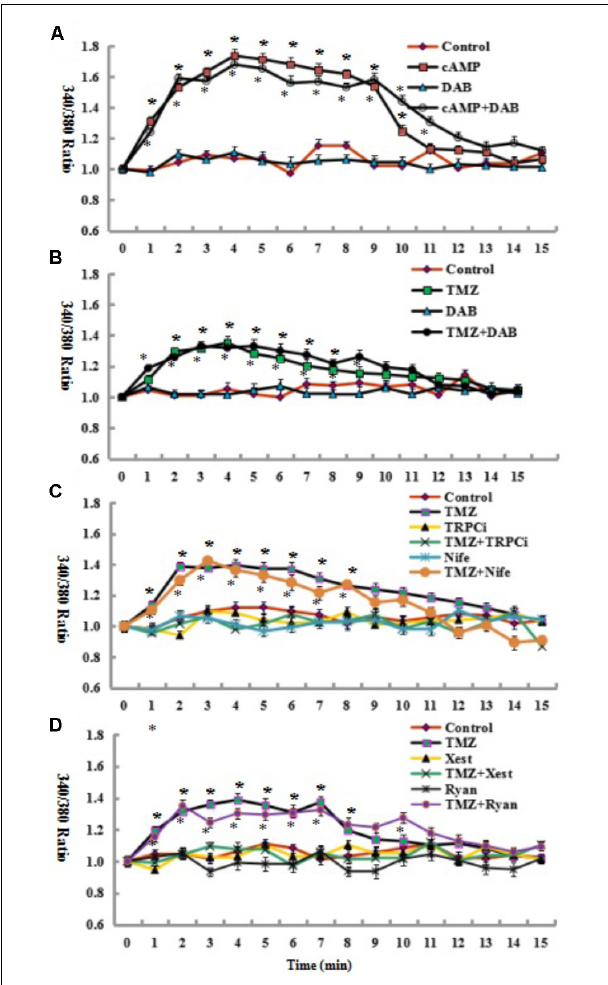
FIGURE 3 | Glycogenolysis is not required for the increase in [Ca 2 + ] i induced by the addition of 3 µ M cAMP or 5 µ M TMZ. (A) Following the incubation of fura-2-loaded cells in saline solution for 2 min and a subsequent washing step, the cells were perfused either in a similar solution or in a solution to which an additional 3 µ M cAMP had been added at zero time. In some experiments, 10 mM DAB, an inhibitor of glycogenolysis, was added 2 min before the addition of cAMP. All results (340/380 fluorescence ratio of fura-2) after the addition of cAMP and cAMP plus DAB were significantly different ( P < 0.05) from control conditions. (B) An increase in [Ca 2 + ] i by 5 µ M TMZ added at zero time was similarly unaffected by 10 mM DAB, added as in (A) . All results after the addition of TMZ and TMZ plus DAB were significantly different ( P < 0.05) from control conditions. (C,D) An increase in [Ca 2 + ] i by 5 µ M TMZ added at zero time was prohibited by the addition of 2 µ g/mL TRPC1 neutralizing antibody (TRPCi) and 1 µ M Xestspongin C (Xest), but not inhibited by 1 µ M Nifedipine (Nife), or 1 µ M Ryanodine (Ryan), added as in (A) . All results after the addition of TMZ, TMZ plus Nife, and TMZ Plus Ryan were significantly different ( P < 0.05) from control conditions. Results represent means from 38 to 81 cells on three to five individual coverslips. SEM values are indicated by vertical bars. ∗ Indicates a statistically significant ( P < 0.05) difference from the drug-free group at the same time point.